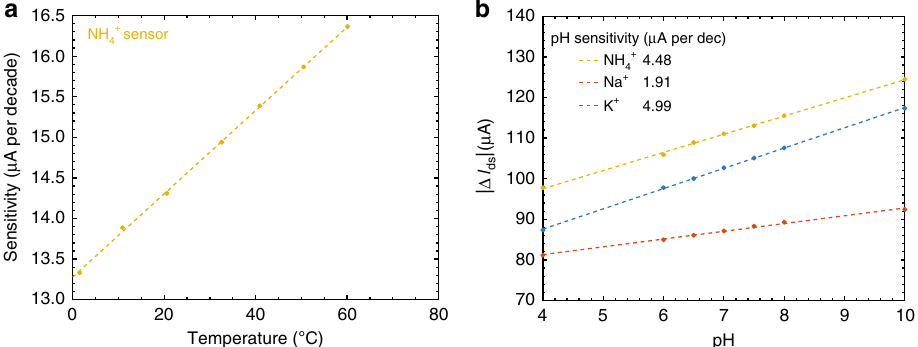
ISFET with respect to temperature. 4